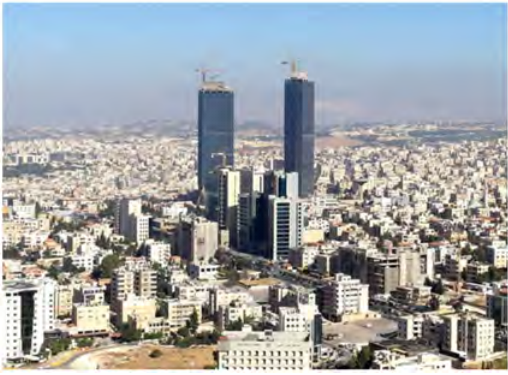
Figure 14. The current situation of the Jordan Gate (Amman Gate) project. Source: Jordan Times (2016)